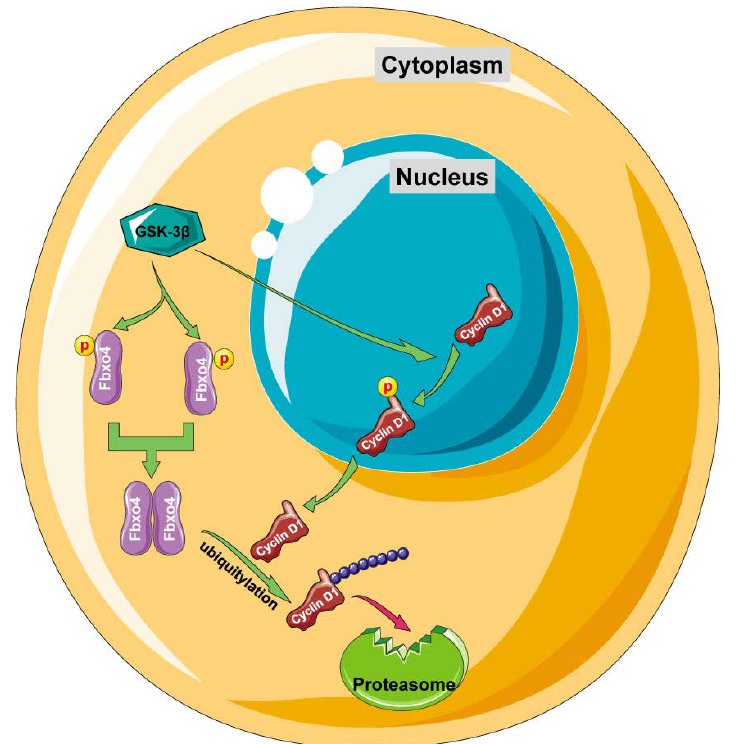
Figure 5. The detailed mechanism of how Fbxo4 mediates the ubiquitylation and degradation of cyclin D1. GSK-3 β phosphorylates cyclin D1 at Thr-286 that facilitates its translocation from nucleus to cytoplasm. GSK-3 β also phosphorylates Fbxo4 at Ser-12/Ser-11, promotes the homodimerization and activation of Fbxo4. In the cytoplasm, Fbxo4 catalyzes the ubiquitylation of cyclin D1 that targets it for proteasome-mediated degradation.